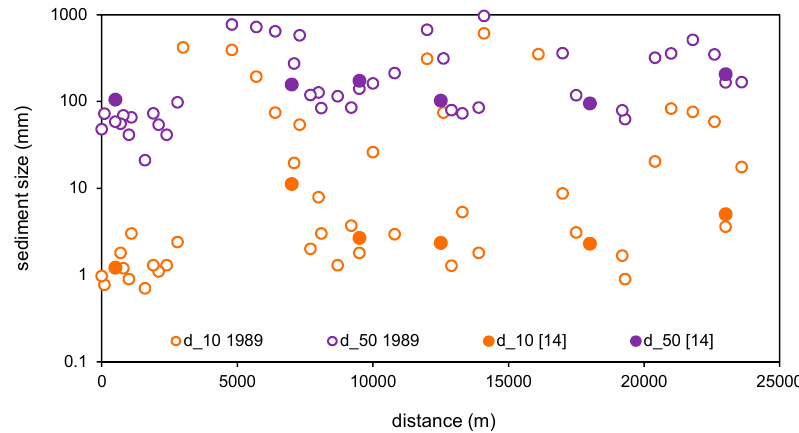
Figure 2. Longitudinal profile of the river bed in the last 9.5 km before the confluence, up to the town of Torre Santa Maria in Figure 1.